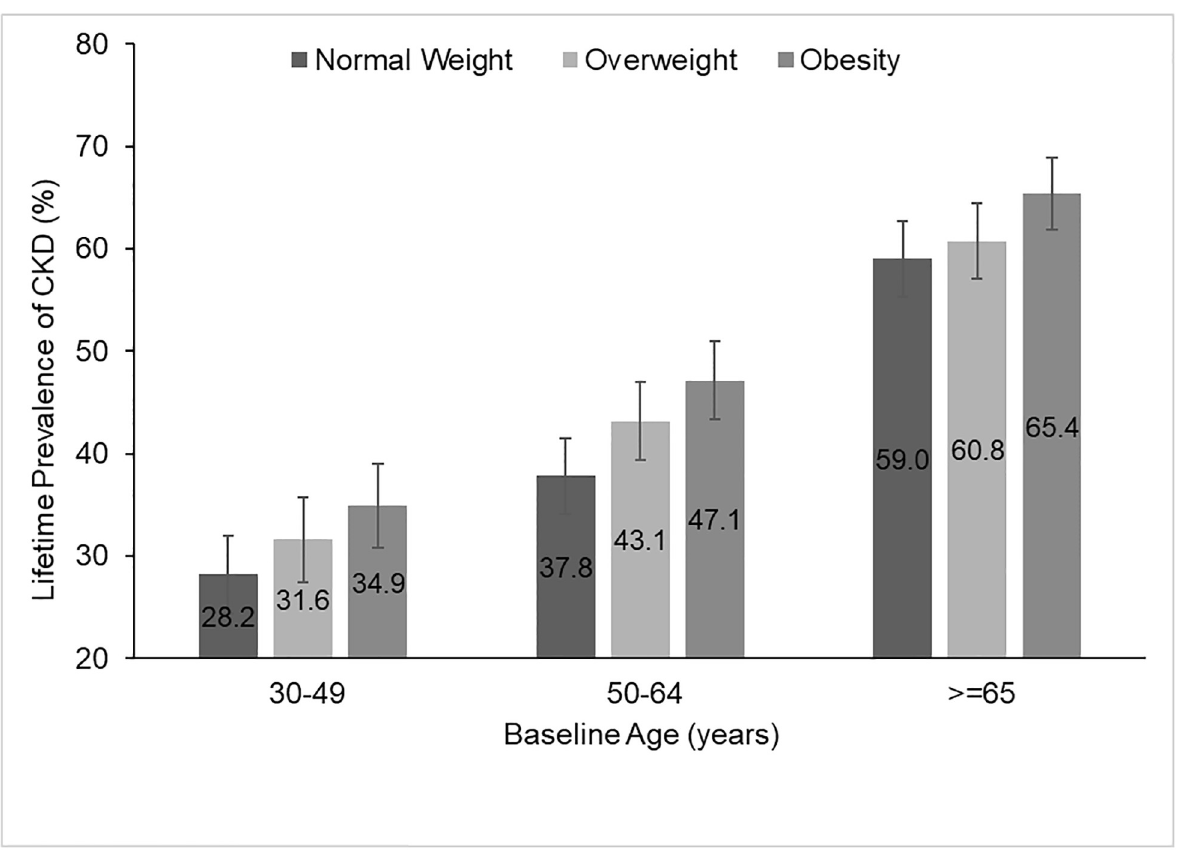
Fig 2. Lifetime risk of any CKD, by baseline BMI category and age. The difference in lifetime risk of any CKD between persons age 50–64 with obesity and normal weight was statistically significant at the 1% level. No other differences were statistically significant. Abbreviations: CKD = Chronic Kidney Disease, BMI = Body Mass